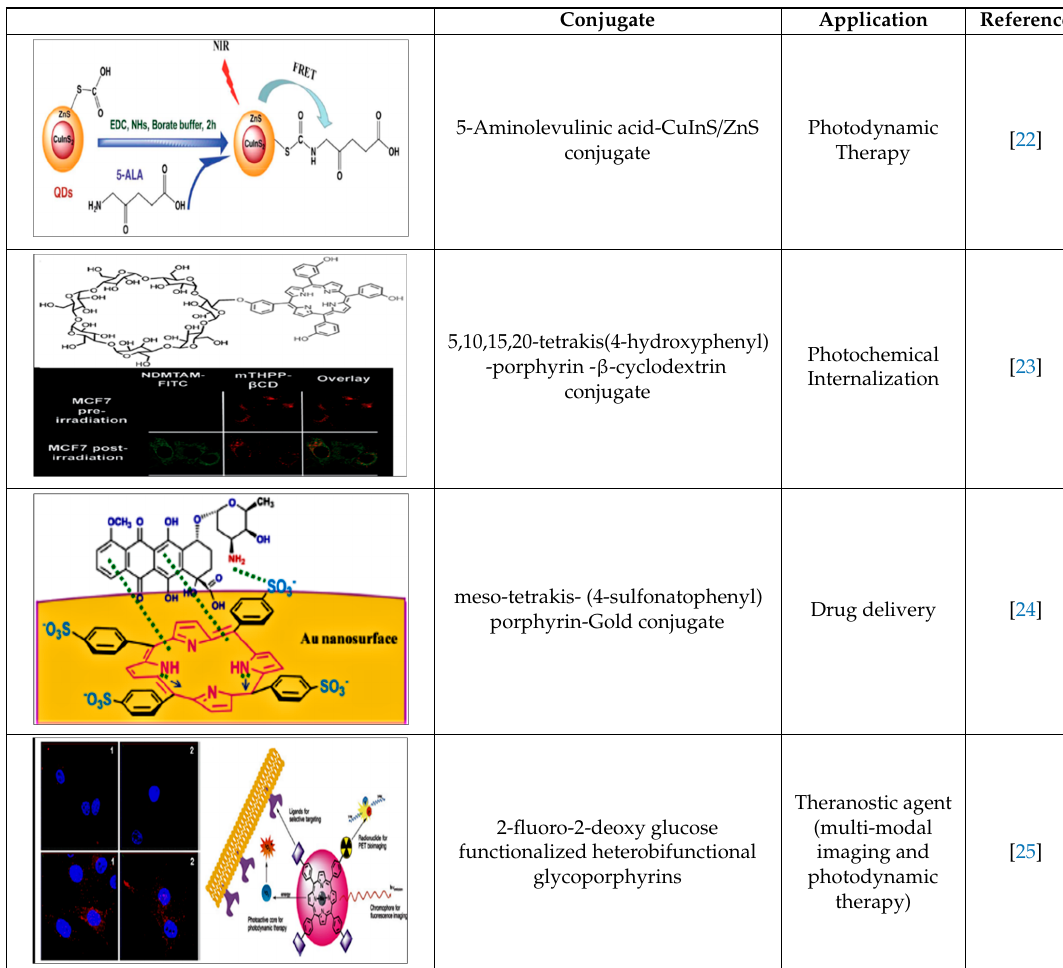
Table 1. Porphyrin conjugated systems.